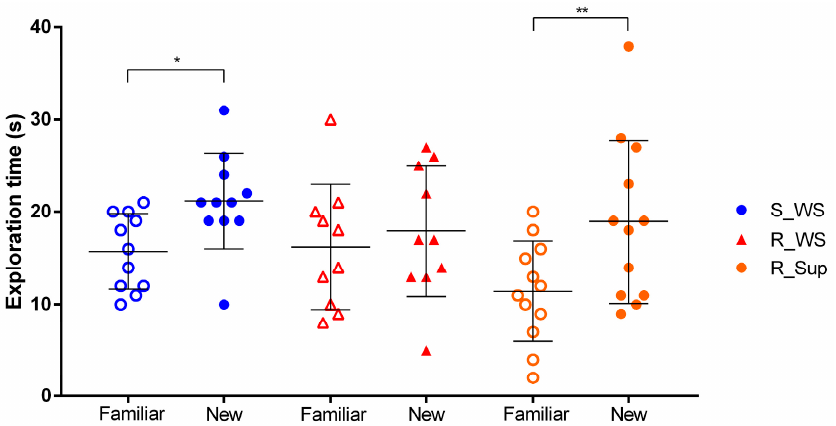
Figure 2. Exploration time of familiar and new objects in the object recognition task (ORT). The graphic shows the exploration time of each object—familiar or new—among the experimental groups. Animals from the sham group (S: F- ± 4.1, N- ± 5.2, n = 11) spent more time exploring the new object, as expected—* p < 0.05. Rotenone administration (R_WS: F- ± 6.8, N- ± 7.0, n = 10) led to an impairment in object recognition memory ( p = 0.80), which was prevented in supplemented animals (R_Sup: F- ± 5.4, N- ± 8.8, n = 12)—** p < 0.01. Data are expressed as mean